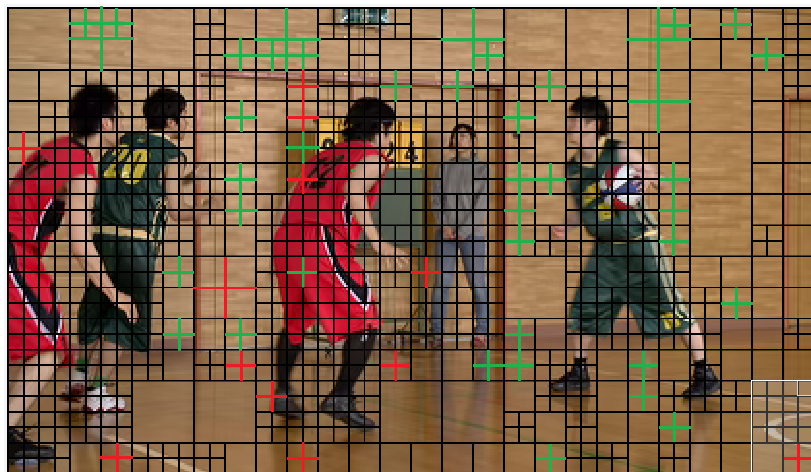
Figure 14. Partition result of the 200th frame in sequence BasketballPass encoded under QP 22 by encoder HM16.7, in which the proposed ABTFA with BD-rate loss constraint 0.9% is applied. Black line represents the same partition results as those of original HM16.7. Green line represents boundaries of CUs, which are split by original HM16.7 but are not split by ABTFA. Boundaries of CUs, that are decided non-split by original HM16.7 but are split by ABTFA, are shown with red